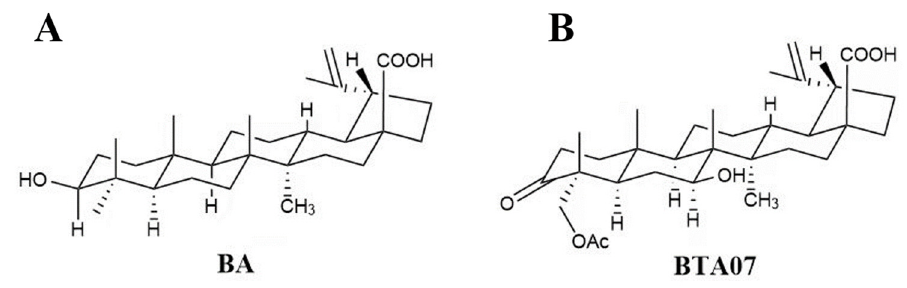
Figure 1. The structures of ( A ) betulinic acid and ( B ) BTA07.